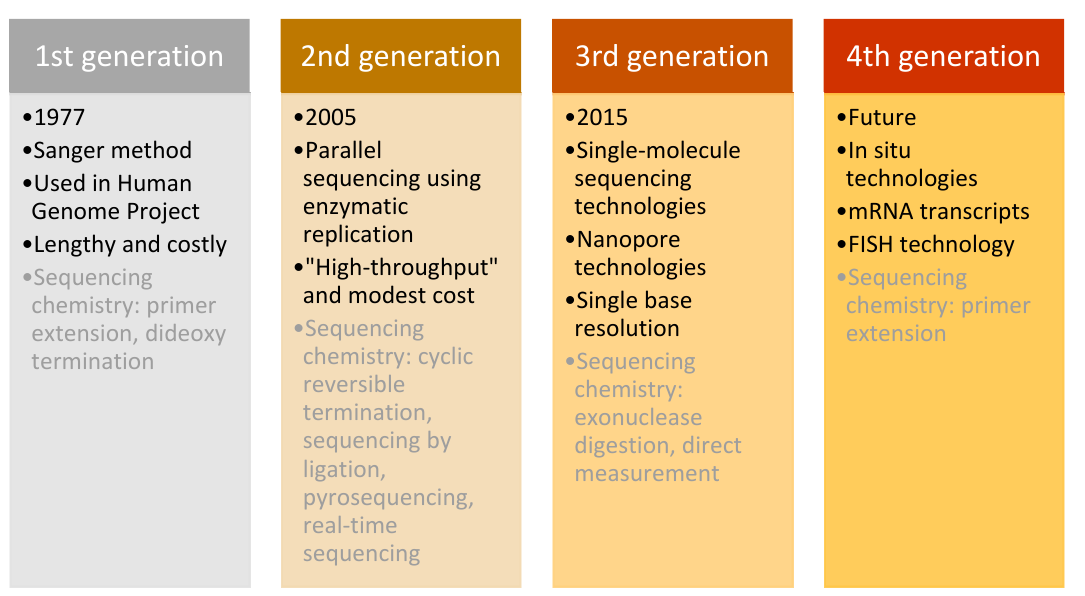
Figure 7. Schematic presentation of the four generations of DNA sequencing.